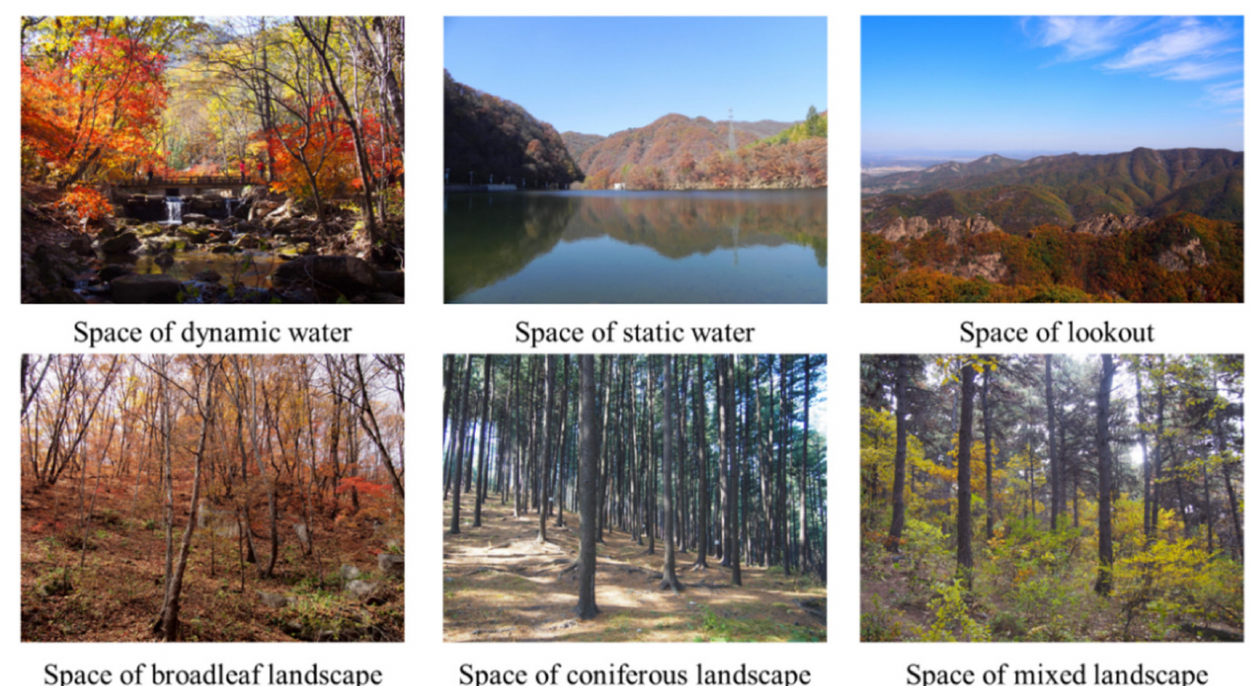
Figure 2. Experimental materials. This figure was created by Yu Gao (Shenyang Agricultural